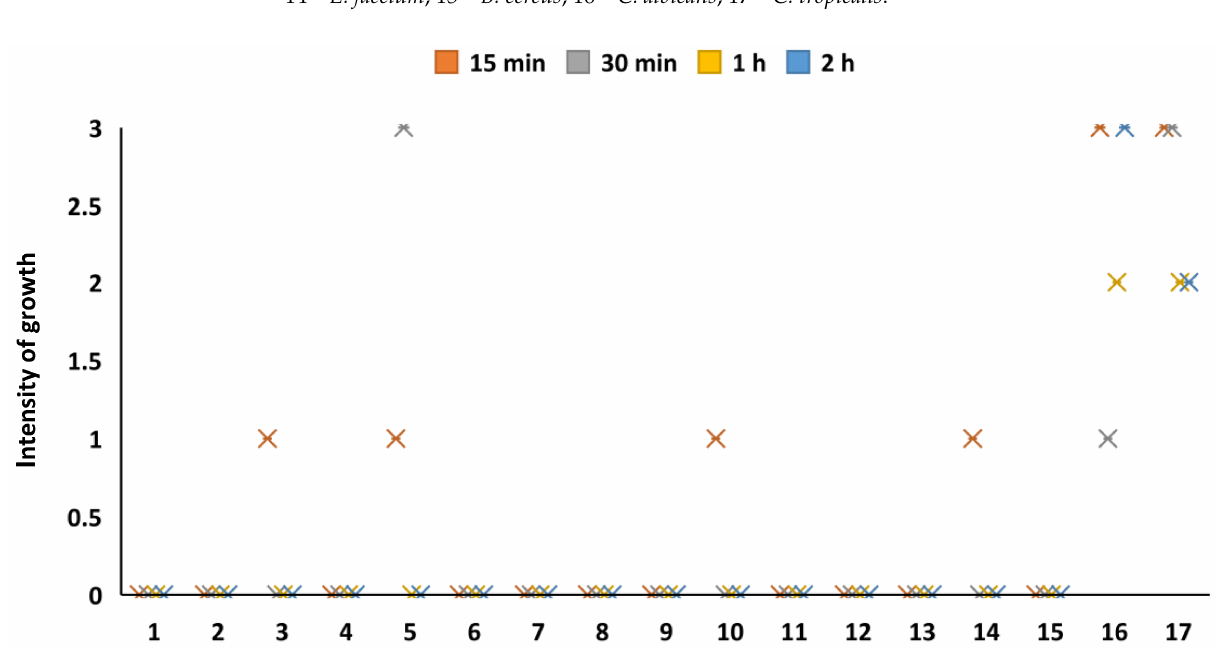
Figure 8. Antimicrobial potential of CuO coatings with indirect exposure to microorganisms. 1— E. cloacae , 2— E. coli , 3— K. pneumoniae , 4— P. mirabilis , 5— S. enterica , 6— C. freundii , 7— A. hydrophila , 8— A. baumannii , 9— P. aeruginosa , 10— P. multocida , 11— S. aureus , 12— S. haemolyticus , 13— E. faecalis , 14— E. faecium , 15— B. cereus , 16— C. albicans , 17— C. tropicalis.